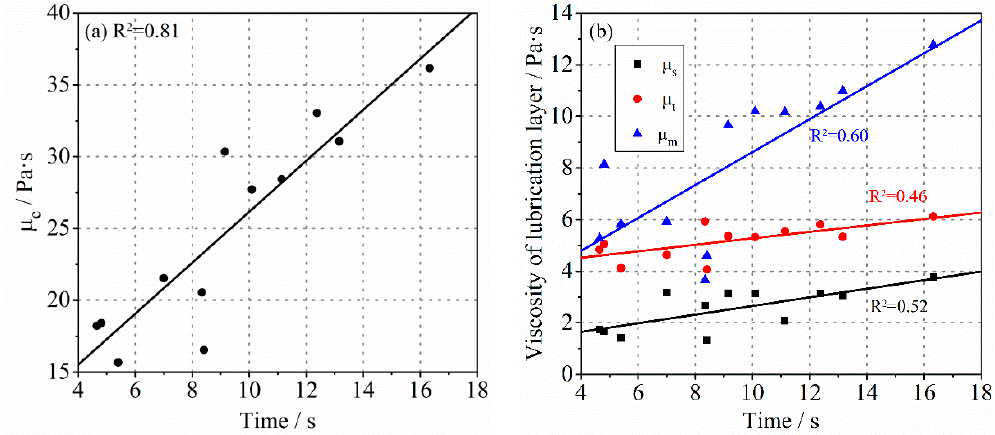
Figure 8. The relationship between the V-Funnel flow time of concrete and the plastic viscosity of ( a ) bulk concrete or ( b ) lubrication layer.